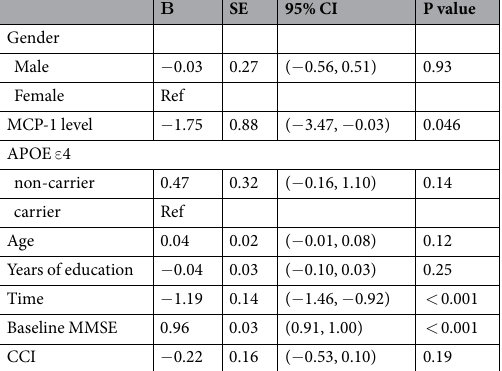
Table 4. Results of the generalized estimating equation analyzing the effect of 2-year MMSE changes in patients with AD and MCI. Adjusted for age, years of education, gender, time, APOE ε 4 carrier, and baseline MMSE. MMSE, Mini-Mental Status Examination; AD, Alzheimer’s disease; MCI, mild cognitive impairment; MCP-1, Monocyte chemoattractant protein-1; APOE, apolipoprotein E; CCI, Charlson comorbidity